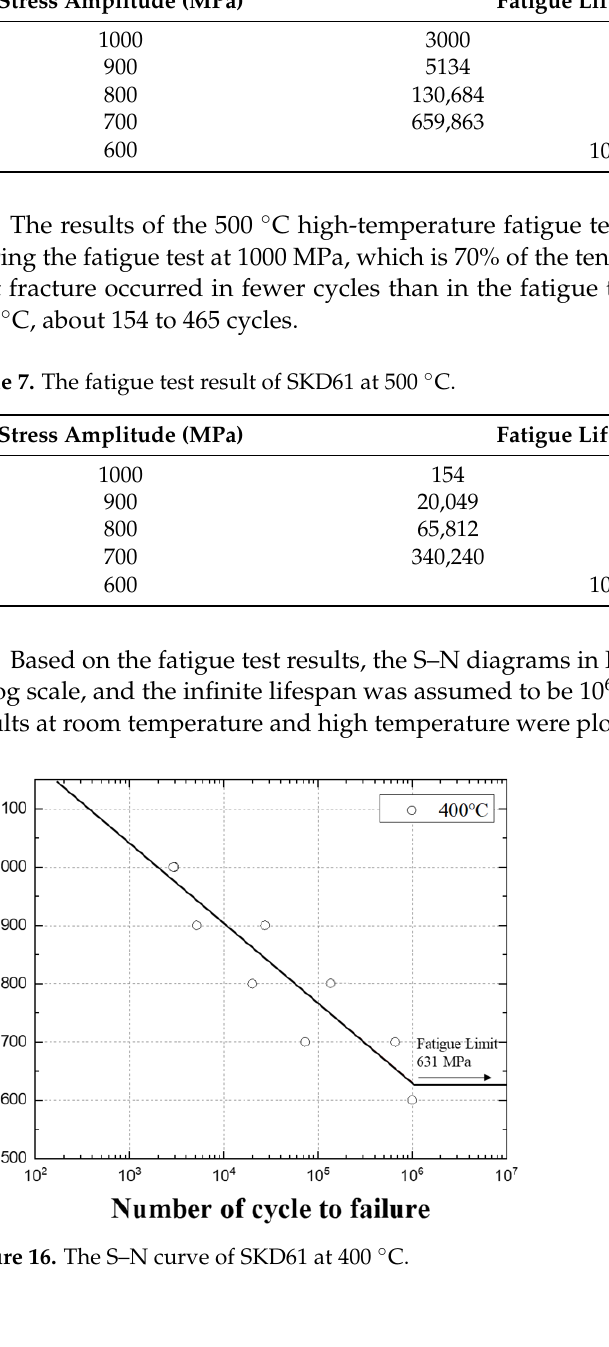
Figure 17. T he S–N curve of SKD61 at 500 °C.